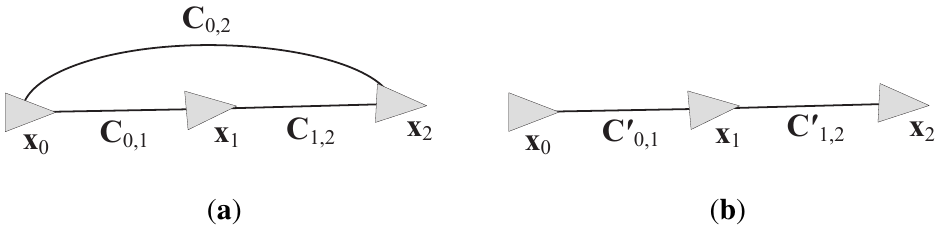
and C (cid:48) are 0 , 1 1 , 2